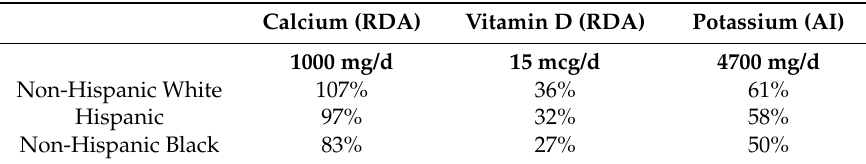
Table 3. Percent of daily recommended intake derived from calculating actual intake divided